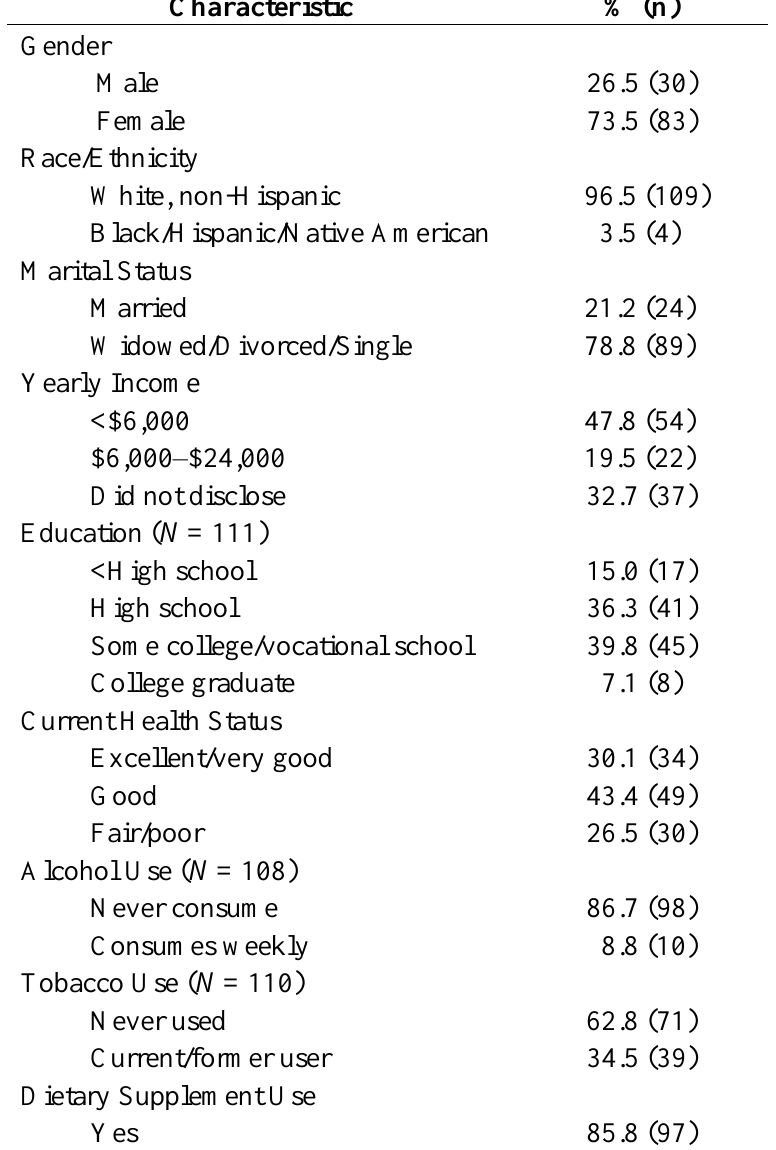
Table 1. Demographics and characteristics of